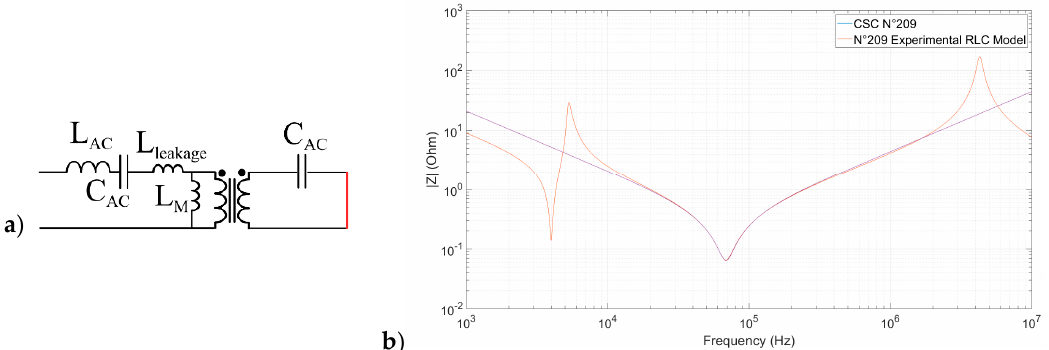
Figure 6. ( a ) One AC link branch impedance characterization for the 3 × 3 CSCs on impedance analyzer (Keysight E4990A) ( b ) One on the impedance plot versus frequency (only one curve is provided since they are superposed due to only small differences.